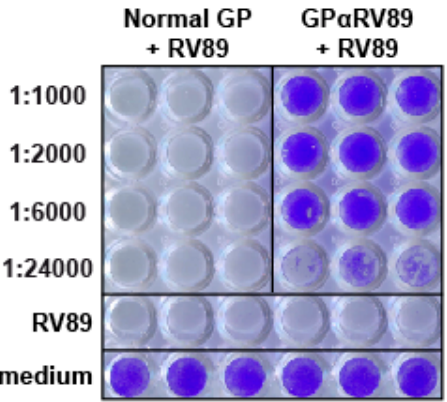
Figure 1. Neutralization of RV infection of HeLa cells with an anti-RV89 guinea pig antiserum. Shown are HeLa cells infected with 50-fold TCID 50 of RV89 which had been preincubated with different dilutions of normal guinea pig serum or of the anti-RV89 antiserum, respectively. For control purposes, cells were only incubated with medium or medium containing 50-fold TCID 50 of RV89. Cells were stained with 0.1% crystal violet. Stained wells contain live/protected cells, while in white-unstained wells, cells are infected/dead.